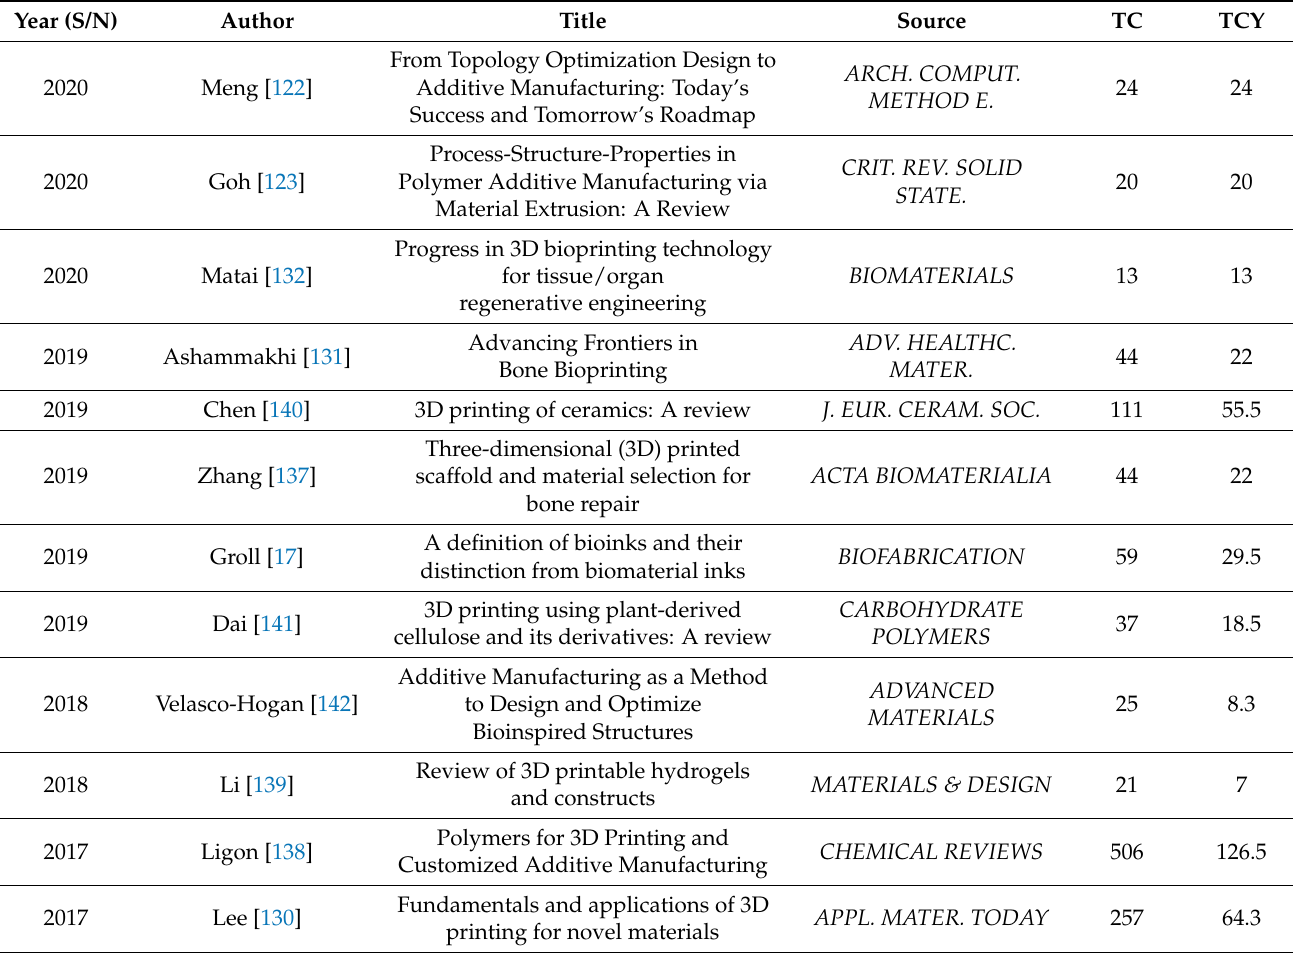
Table 7. Reviews on topic of 3D